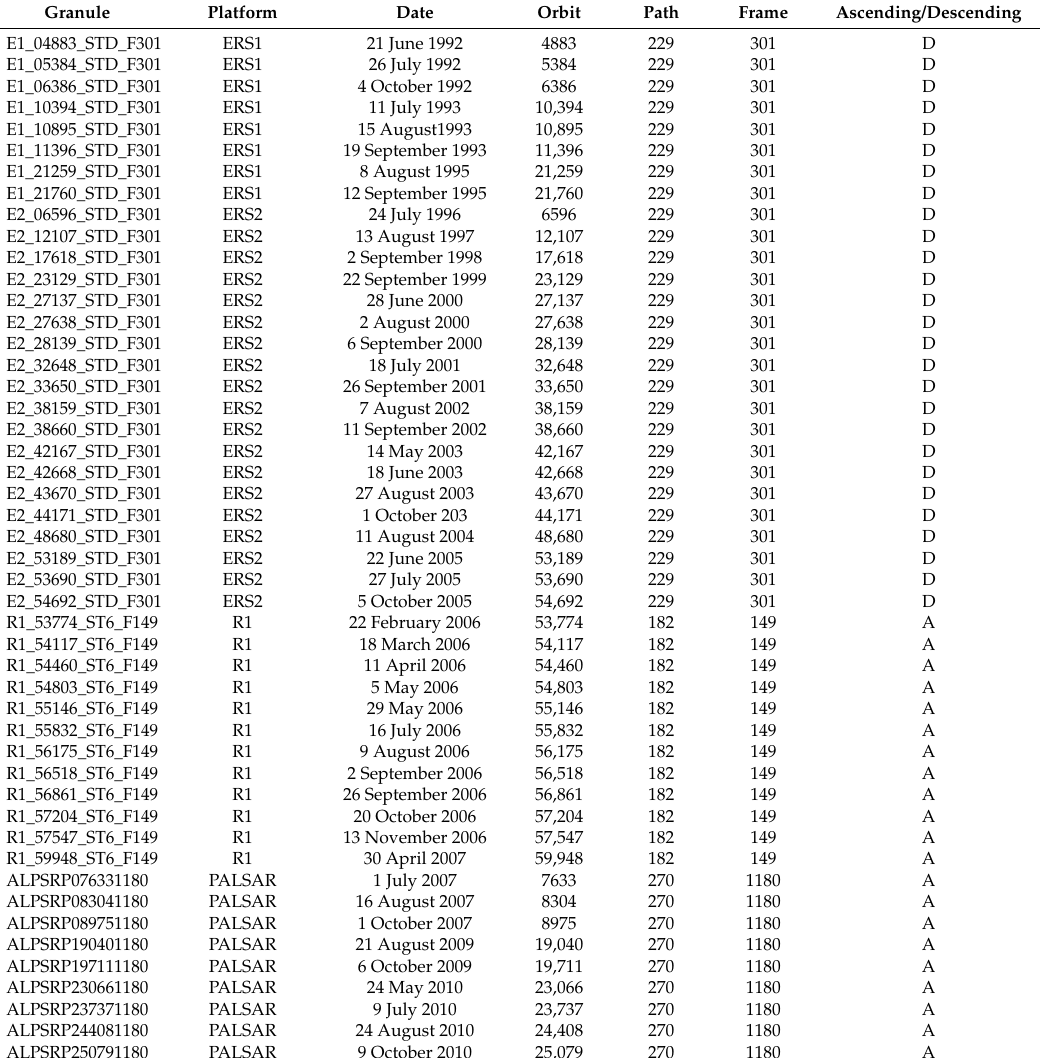
SAR data used to produce interferometric data for the 1986 and 2006 Augustine volcano